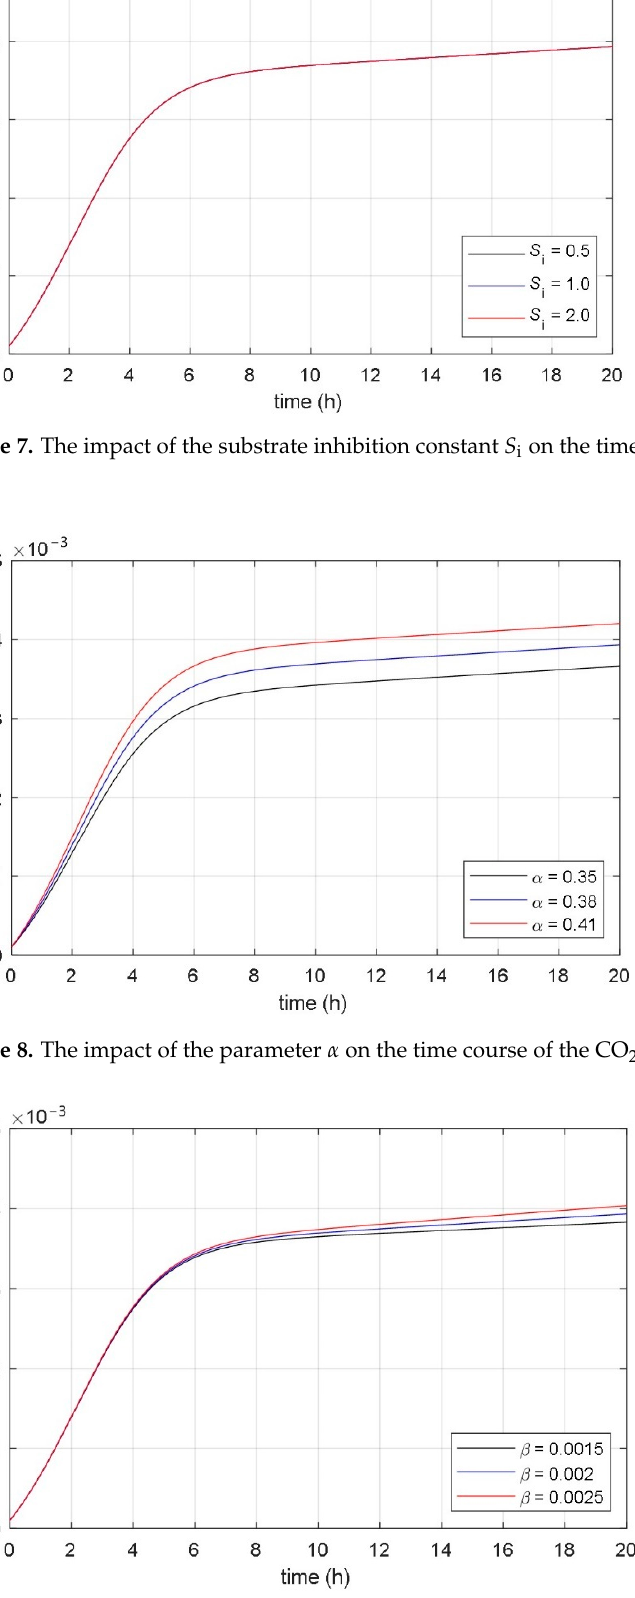
Figure 9. The impact of the parameter β on the time course of the CO 2 concentration.